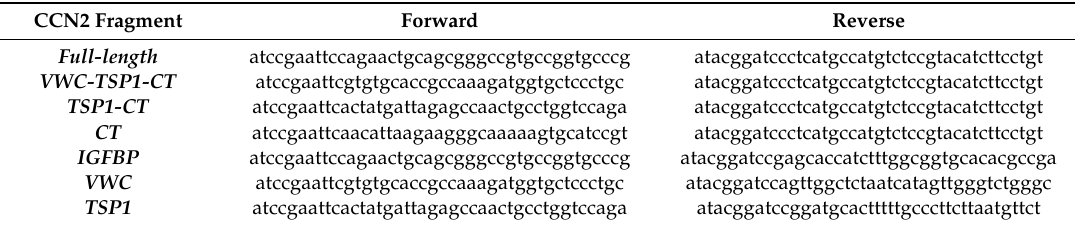
Table 3. Primer sequences for the amplification of the full-length and truncated forms of